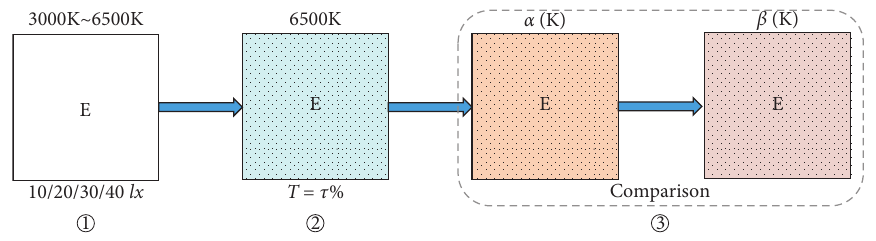
Figure 13: The experimental